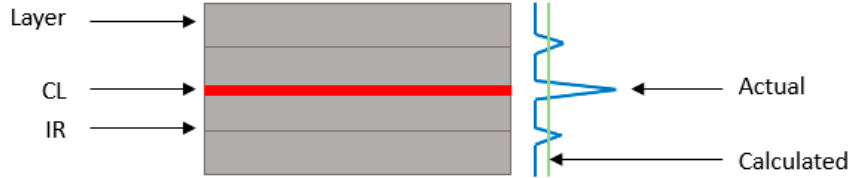
Figure 14. Illustration of the actual and calculated DI testing results.